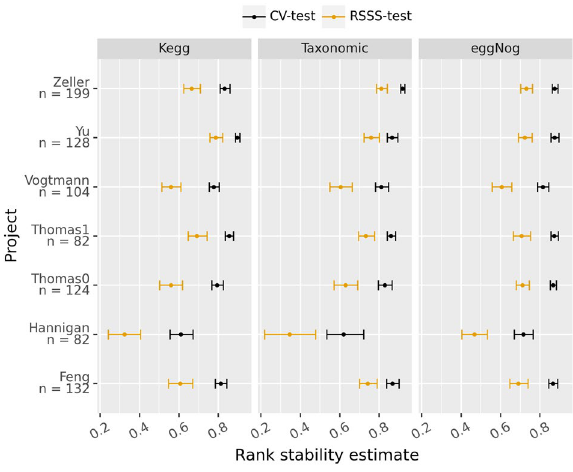
Figure 2. Rank stability estimate (the mean of all the hyperbolic-weighted tau pairwise rank comparisons) along with the 0.25 and 0.75 quantiles for the Random Stability Sub Sampling (RSSS-test) and 20-times tenfold cross validation (CV-test) splitting schemas for each metagenomic profile (KEGG, eggNog and taxonomic) and